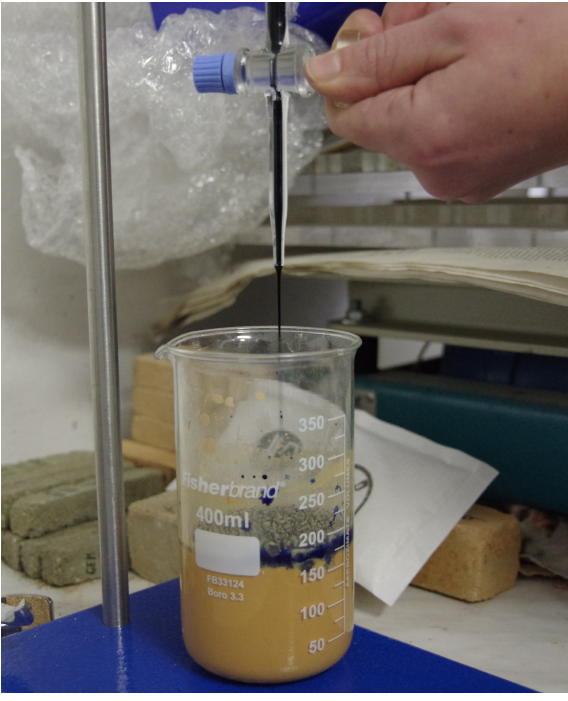
Figure 3. Adding MB solution into the test material suspension.